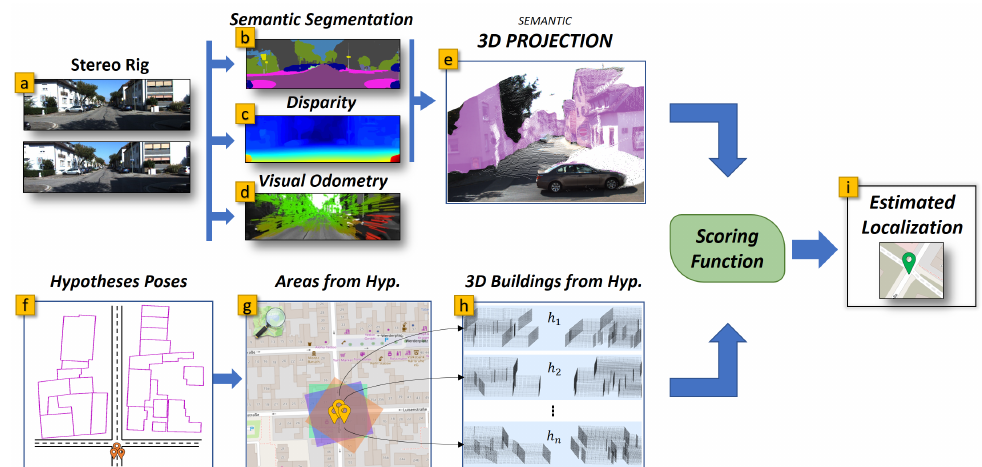
Figure 2. The pipeline of our proposal. A stereo rig ( a ) is used to produce a semantic segmentation ( b ), the disparity ( c ), and the visual odometry ( d ). The disparity and the semantic segmentation are used to produce a point cloud with semantic annotations ( e ). In the meanwhile, for each vehicle pose hypothesis (particle) we define a surrounding area and take the included building outlines ( f , g ). The outlines are then extruded in 3D ( h ) and compared against the semantic point cloud ( e ) to produce a scoring for a particle and, at the end, a localization estimate ( i ).